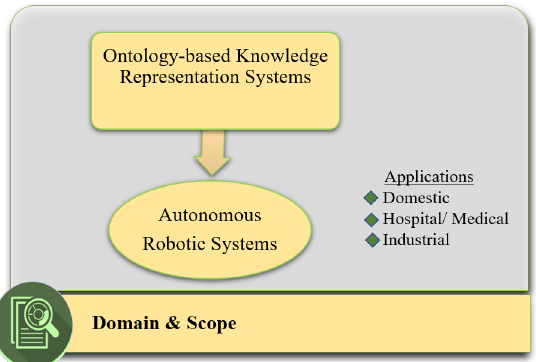
Figure 1. Survey domain and